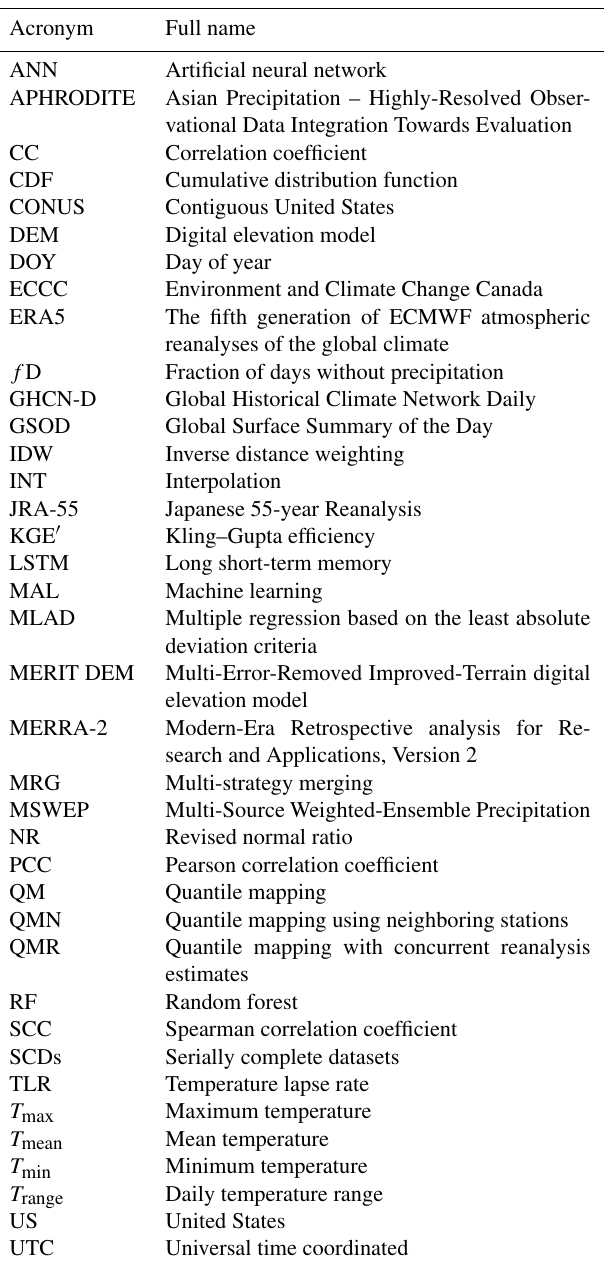
Table A1. Acronyms used in this